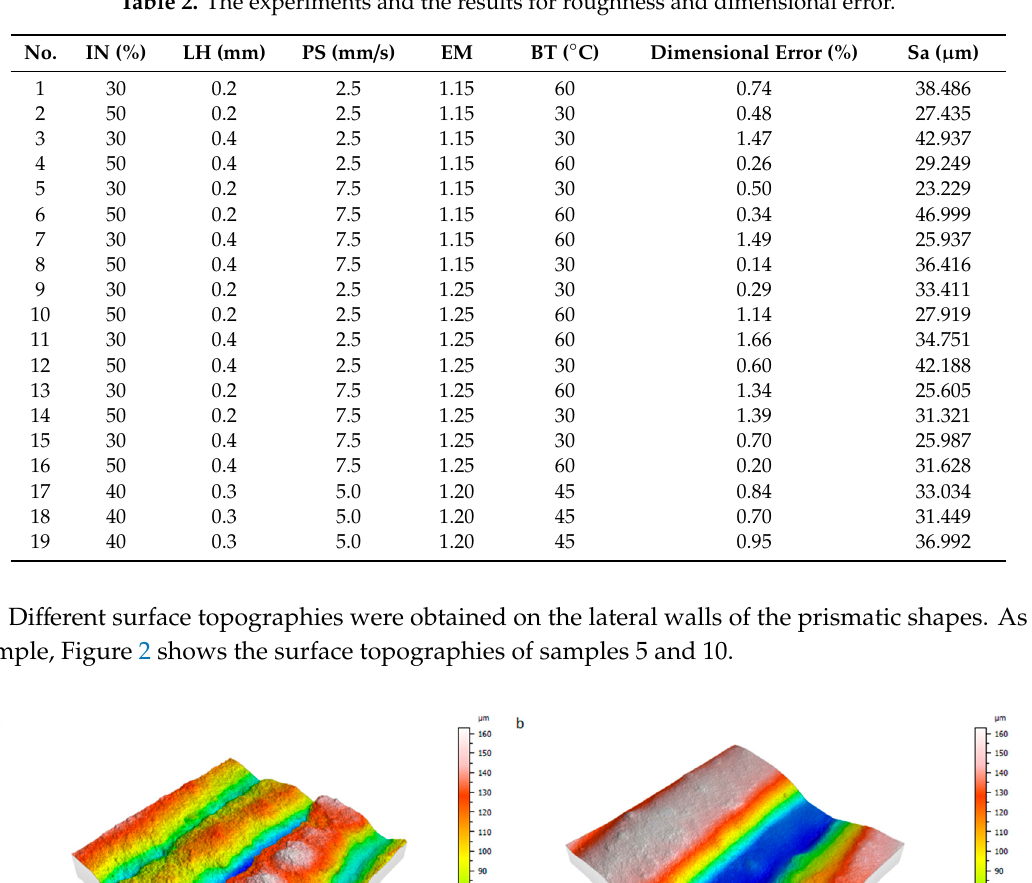
Table 2. The experiments and the results for roughness and dimensional error.